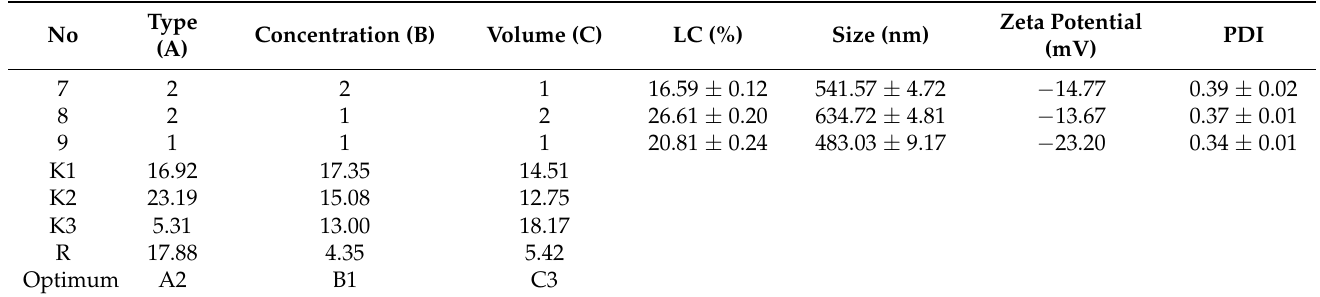
Table 2. The design and results of the orthogonal experiment.